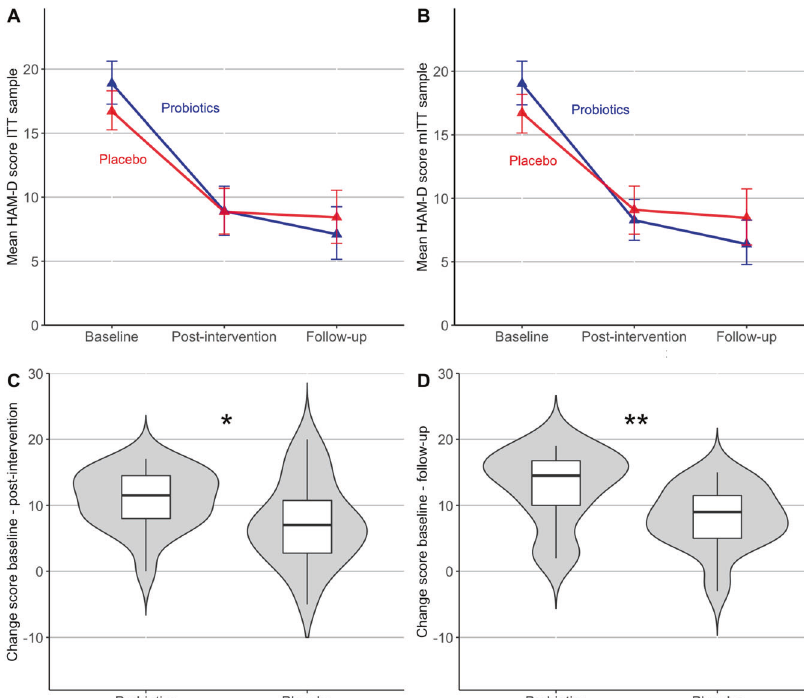
Fig. 1 Trajectories and change scores of depressive symptoms in the probiotics and placebo group. Mean trajectory of scores on the Hamilton Scale for Depression (HAM-D) from baseline to post-intervention (week 4) and follow-up assessment (week 8) in A the intention-to- treat sample (ITT) and B the modi fi ed intention-to-treat sample (mITT). Error bars indicate 95% con fi dence interval (based on a bootstrap). C Change scores from baseline to post-intervention in the mITT sample and D from baseline to